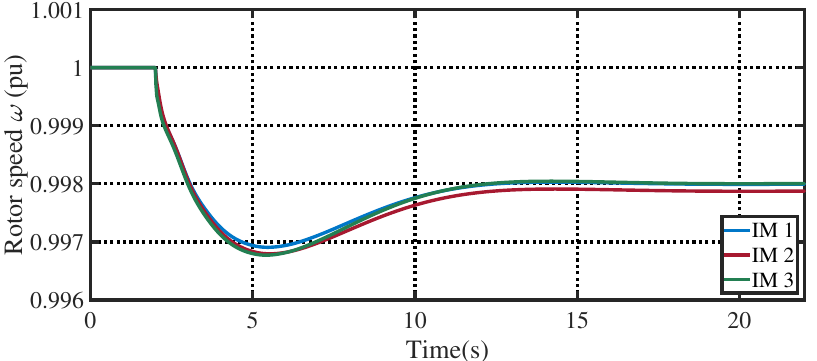
Figure 10. Induction motors’ rotor speed dynamics in the modified IEEE 9-bus system during the under-frequency event.